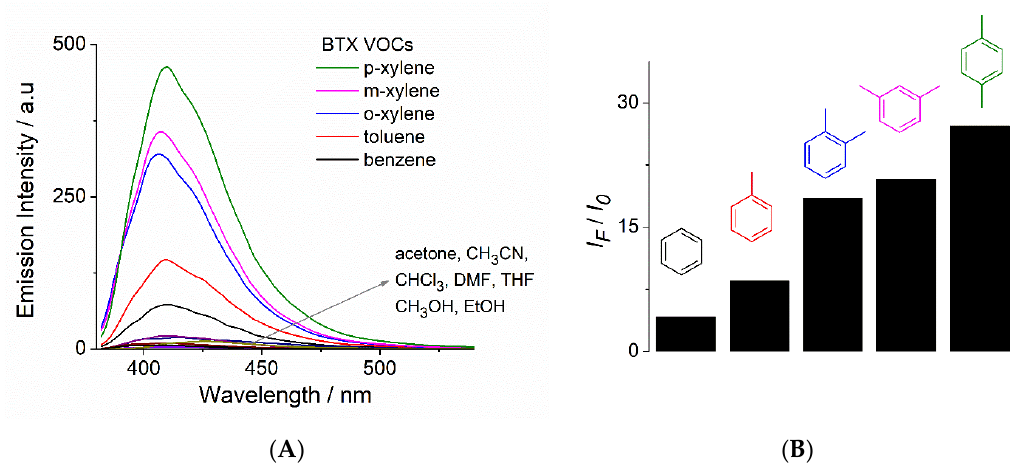
Figure 9. ( A ) Emission spectra of 1 (λ ex = 330 nm) at room temperature in different pure organic solvents and ( B ) fluorescence intensity changes at 409 nm (λ ex = 330 nm) of acetonitrile suspension of 1 upon addition of 40.0 equiv. of benzene, toluene, xylene isomers (BTX).